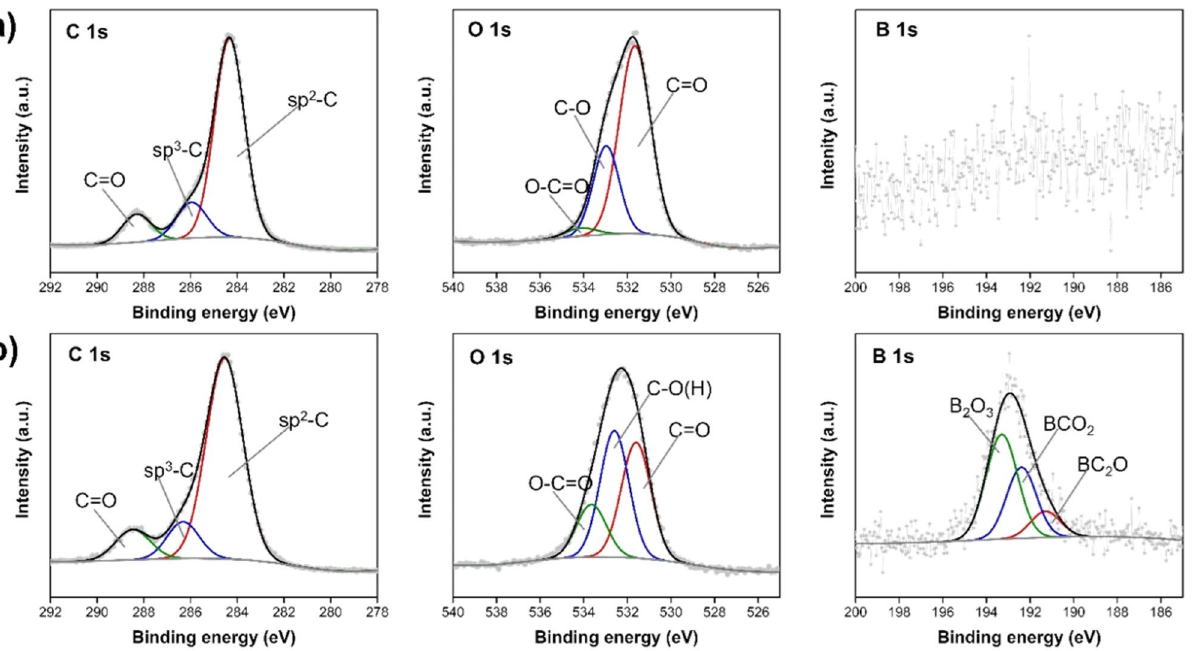
Figure 5. C 1 s, O1s, and B1s XPS spectra of ( a ) PC and ( b ) LC synthesized from TBB via SP at frequency of 100 kHz for 60 min.